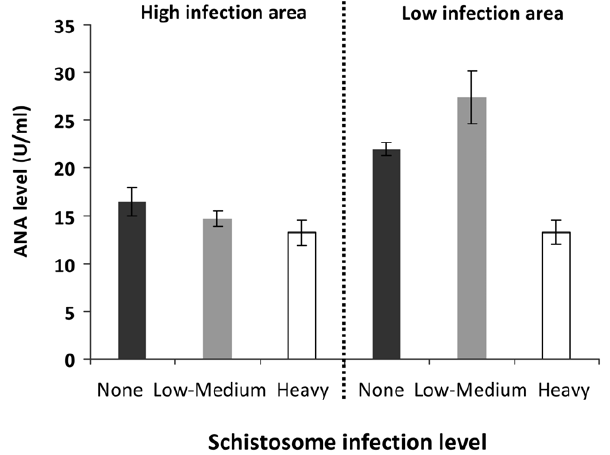
Figure 4 and neither did HIV status (F 1,612 =2.9, p = 0.09) nor participant sex (F 1,612 =1.22, p = 0.26).